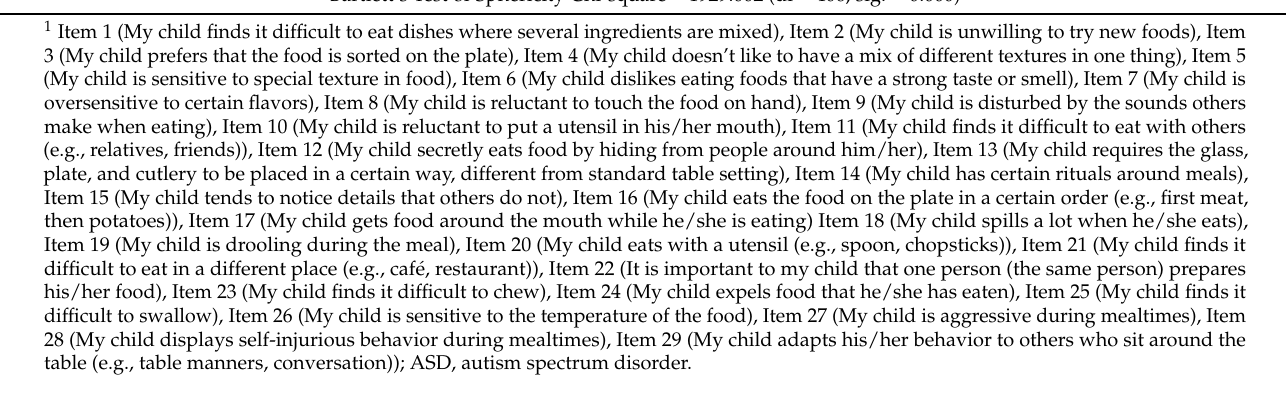
table (e.g., table manners, conversation)); ASD, autism spectrum disorder. The factors that were extracted were categorized into 7 groups: 1. Limited Variety, 2. and 7. Features of